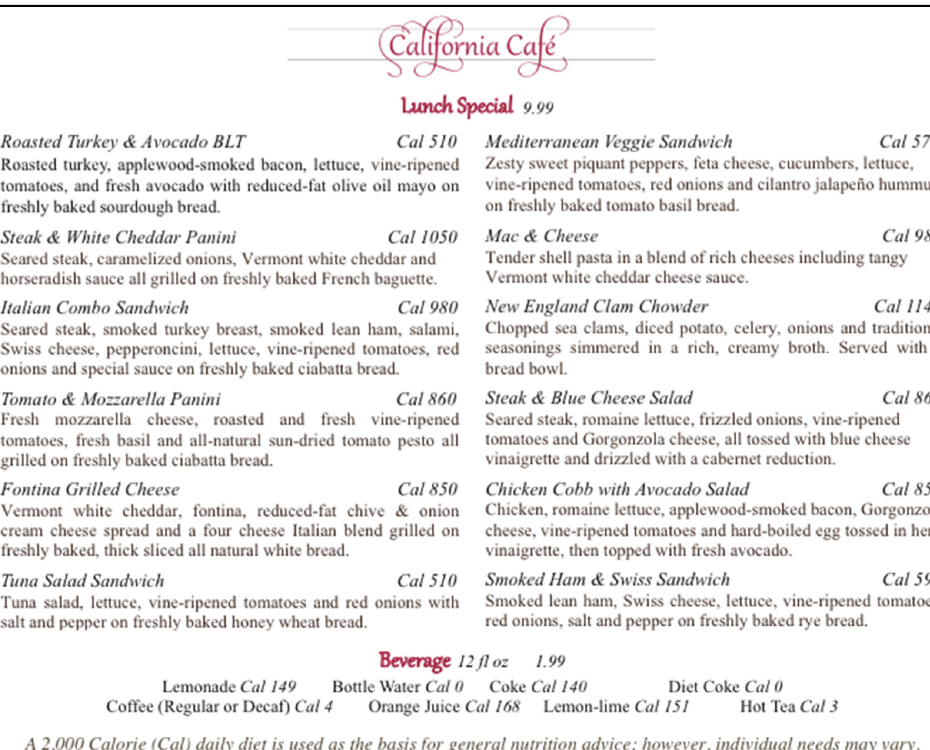
Figure A6. California Cafe First and Last Menu.